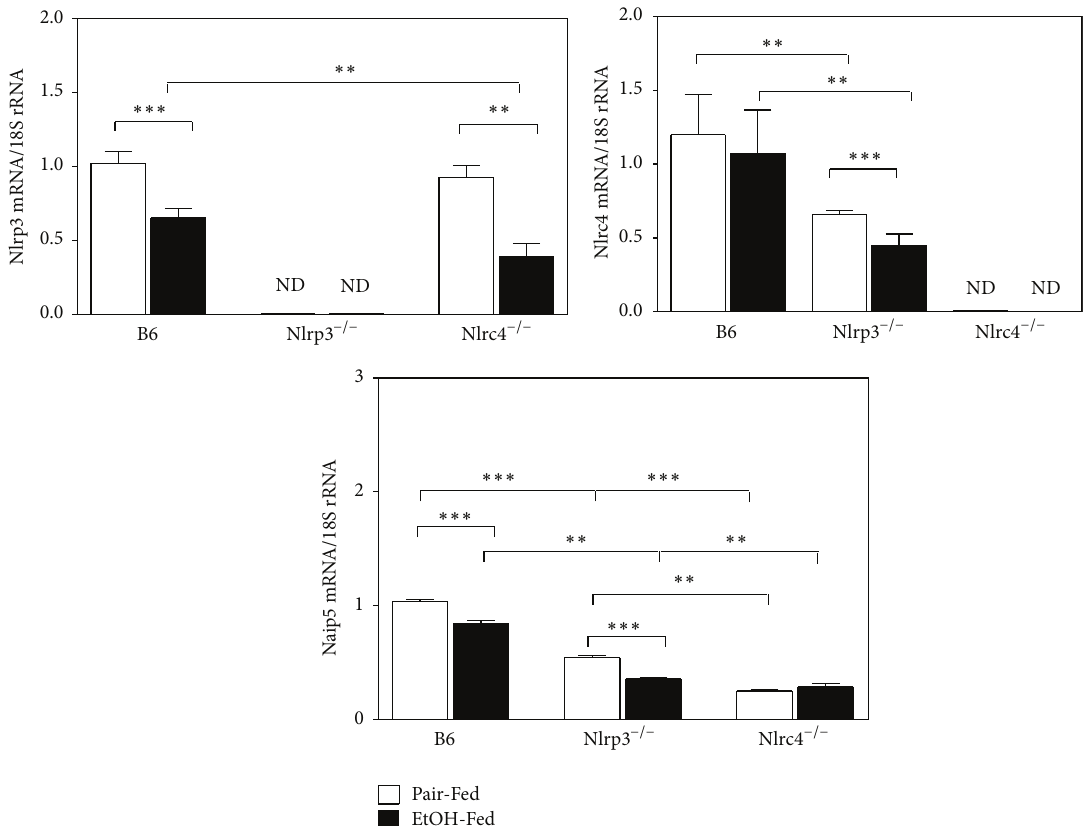
Figure 6: Hepatic expression of Nlrp3, Nlrc4, and Naip5 mRNA. RNA was isolated from C57BL/6J (B6), Nlrp 3 −/− , and Nlrc 4 −/− mice fed Lieber-DeCarliethanol-containingdiet(EtOH-Fed)orpair-fedcontrols(Pair-Fed).ExpressionofNlrp3,Nlrc4,andNaip5wasmeasured.The values are the means ± SEM and normalized with 18S rRNA for 𝑛 = 4 –6 mice per group. Values represent the mean ± SEM with ∗∗ 𝑃 < 0.05 , ∗∗∗ 𝑃 < 0.001 by Student’s 𝑡 -test.